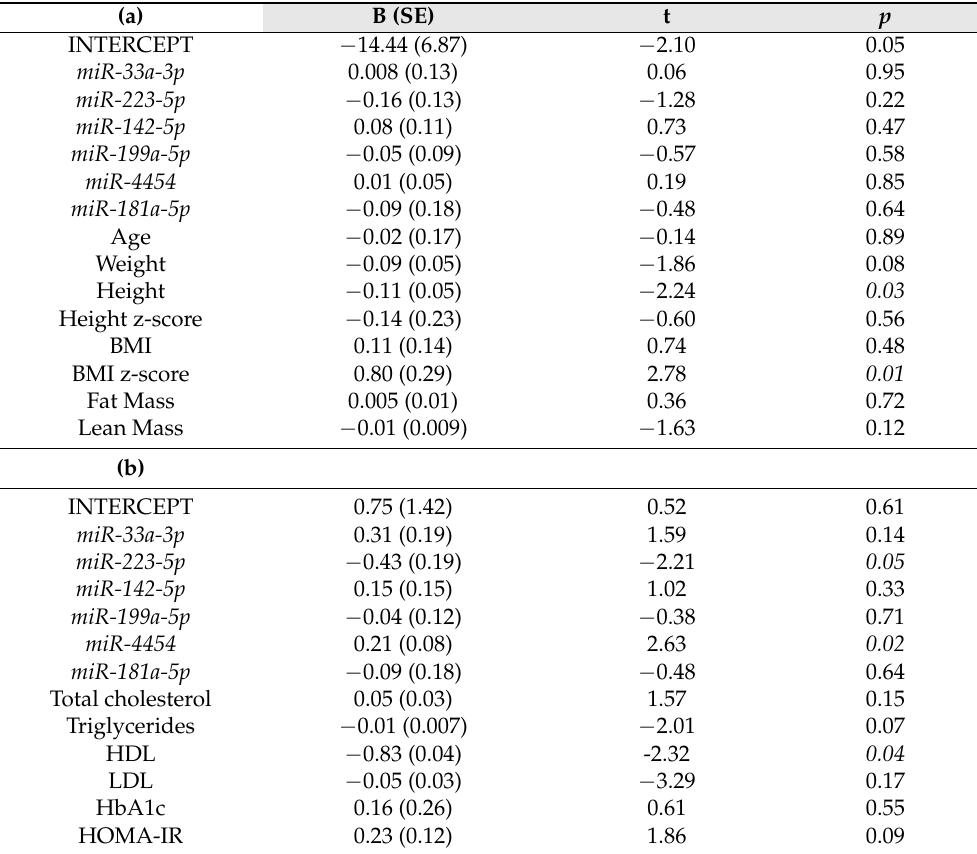
Table 2. (a) independent determinants of obesity (Response Variable: Auxologic Parameters); (b) in- dependent determinants of obesity (Response Variable: Metabolic